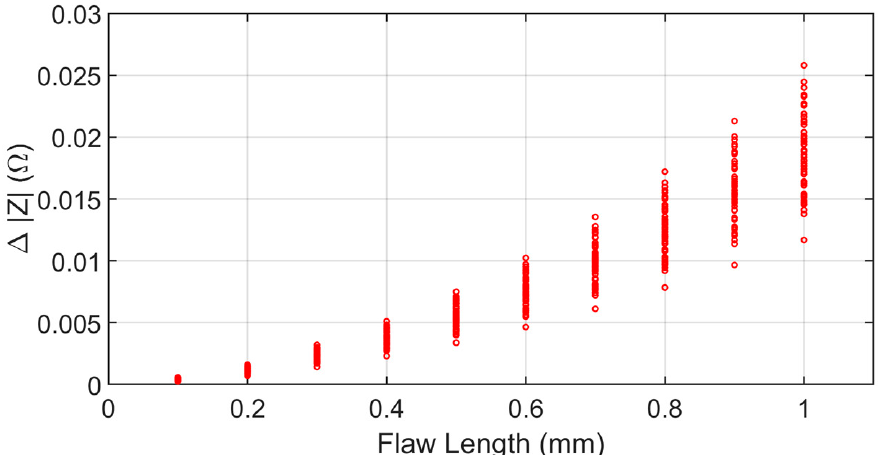
Figure 6. ECT responses simulated by the ACA-SVD based BEM forward solver. The amplitudes of the impedance variations are plotted against the flaw length. The flaw lengths range from 0.1 mm to 1 mm in steps of 0.1 mm. For a given flaw length, 45 predictions are carried out when taking the lift-off distance as the uncertain parameter in a Gaussian distribution.